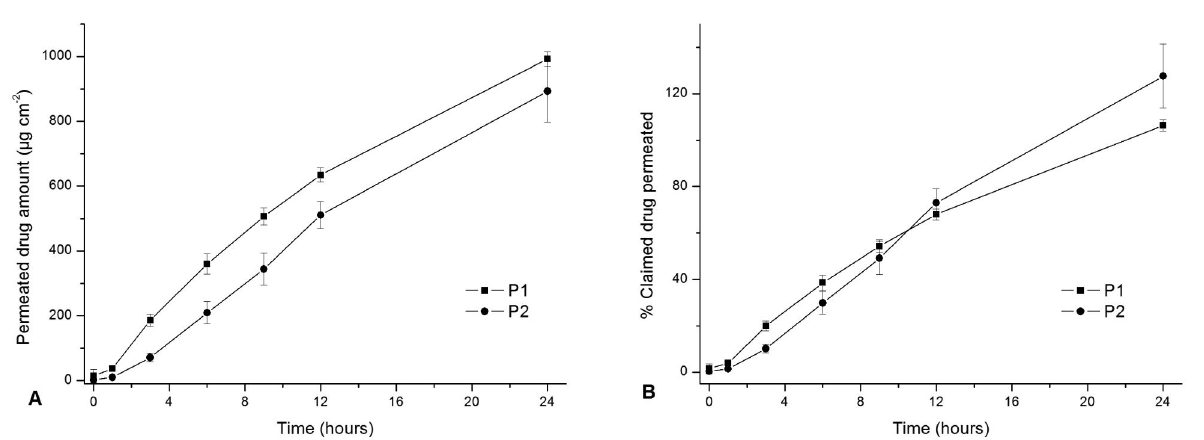
FIGURE 3 - In vitro skin permeation profiles from commercial nicotine patches P1 (■) and P2 (●) using the VDC method, n = 6. Results are expressed as cumulative amount of drug that permeated through the skin (A) and the cumulative % of dose permeated (B).